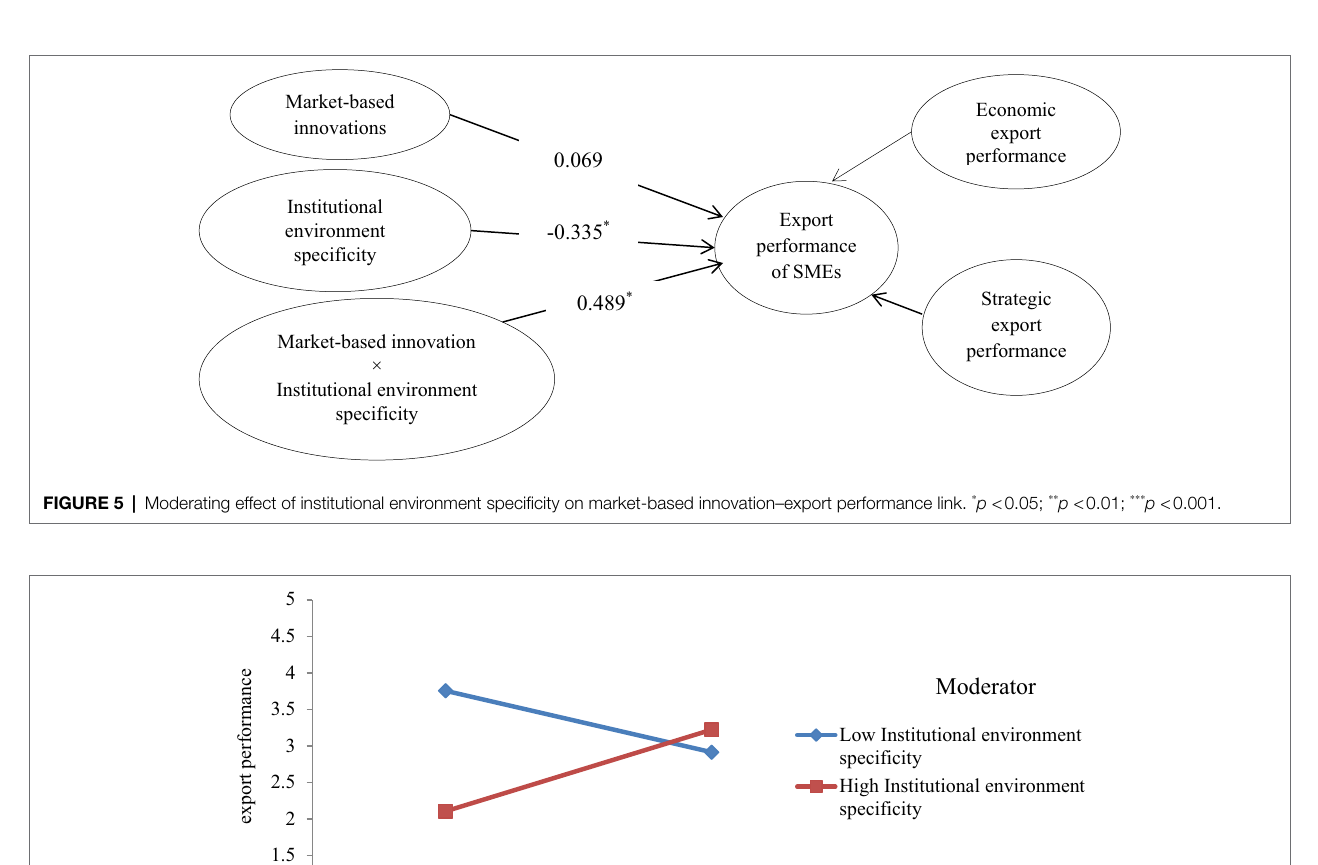
FIGURE 4 | Interaction of model 1.